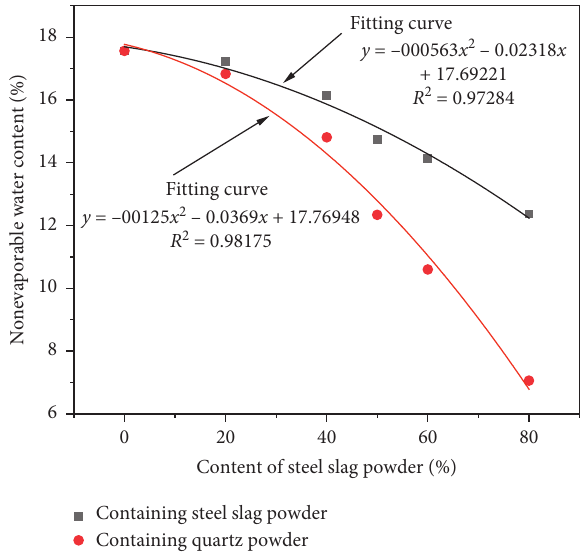
Figure 4: Nonevaporable water content of blended cement con- taining different amounts of steel slag powder. Figure